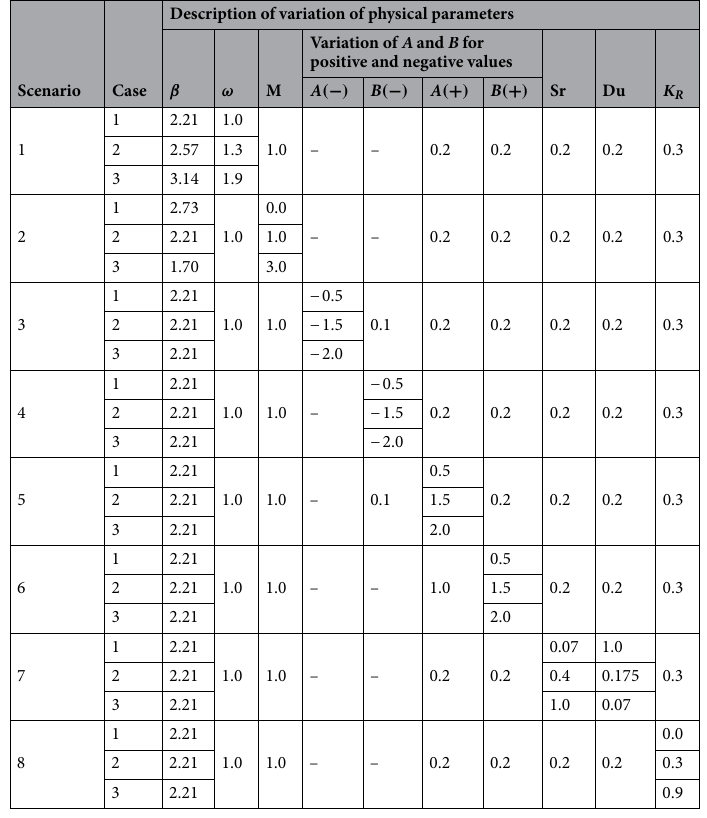
Table 1. Illustration of eight scenarios (1–8) along with cases (1–3) for TFFMFTDECR model.